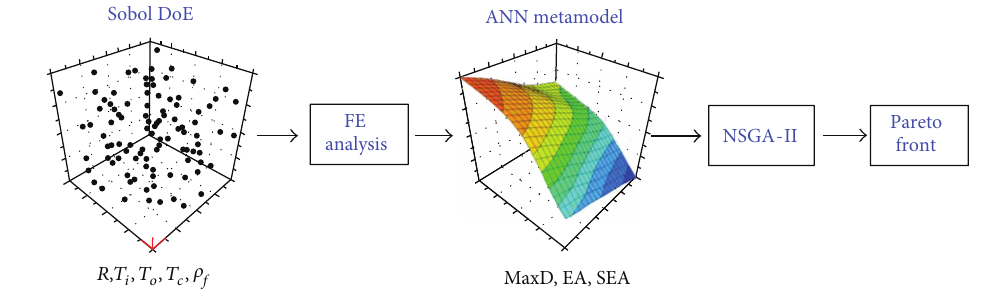
Figure 11: Optimization procedure for curved sandwich panel blast-resistant design.